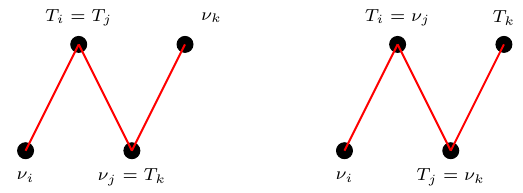
Figure 7.6: Different paths of length 3. (a) T i = T j and ν j = T k , (b) ν j = T i and ν k = T j